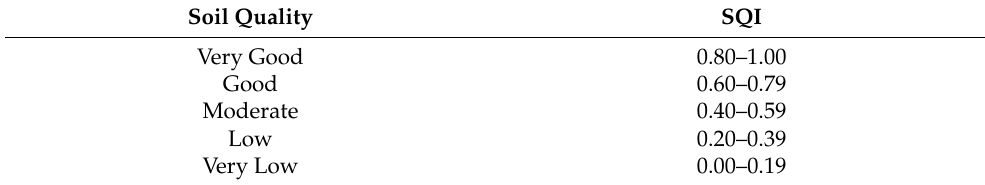
Table 3. Soil Quality Index Characterization